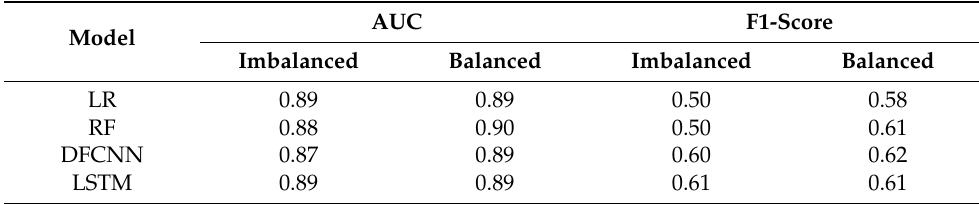
Table 3. Performances of four models under the imbalanced strategy and balanced strategy.